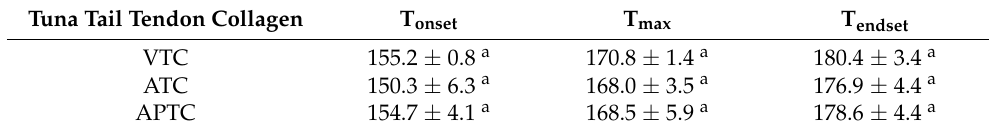
Table 4. DSC thermogram of tuna-tail-tendon collagens. Tuna Tail Tendon Collagen